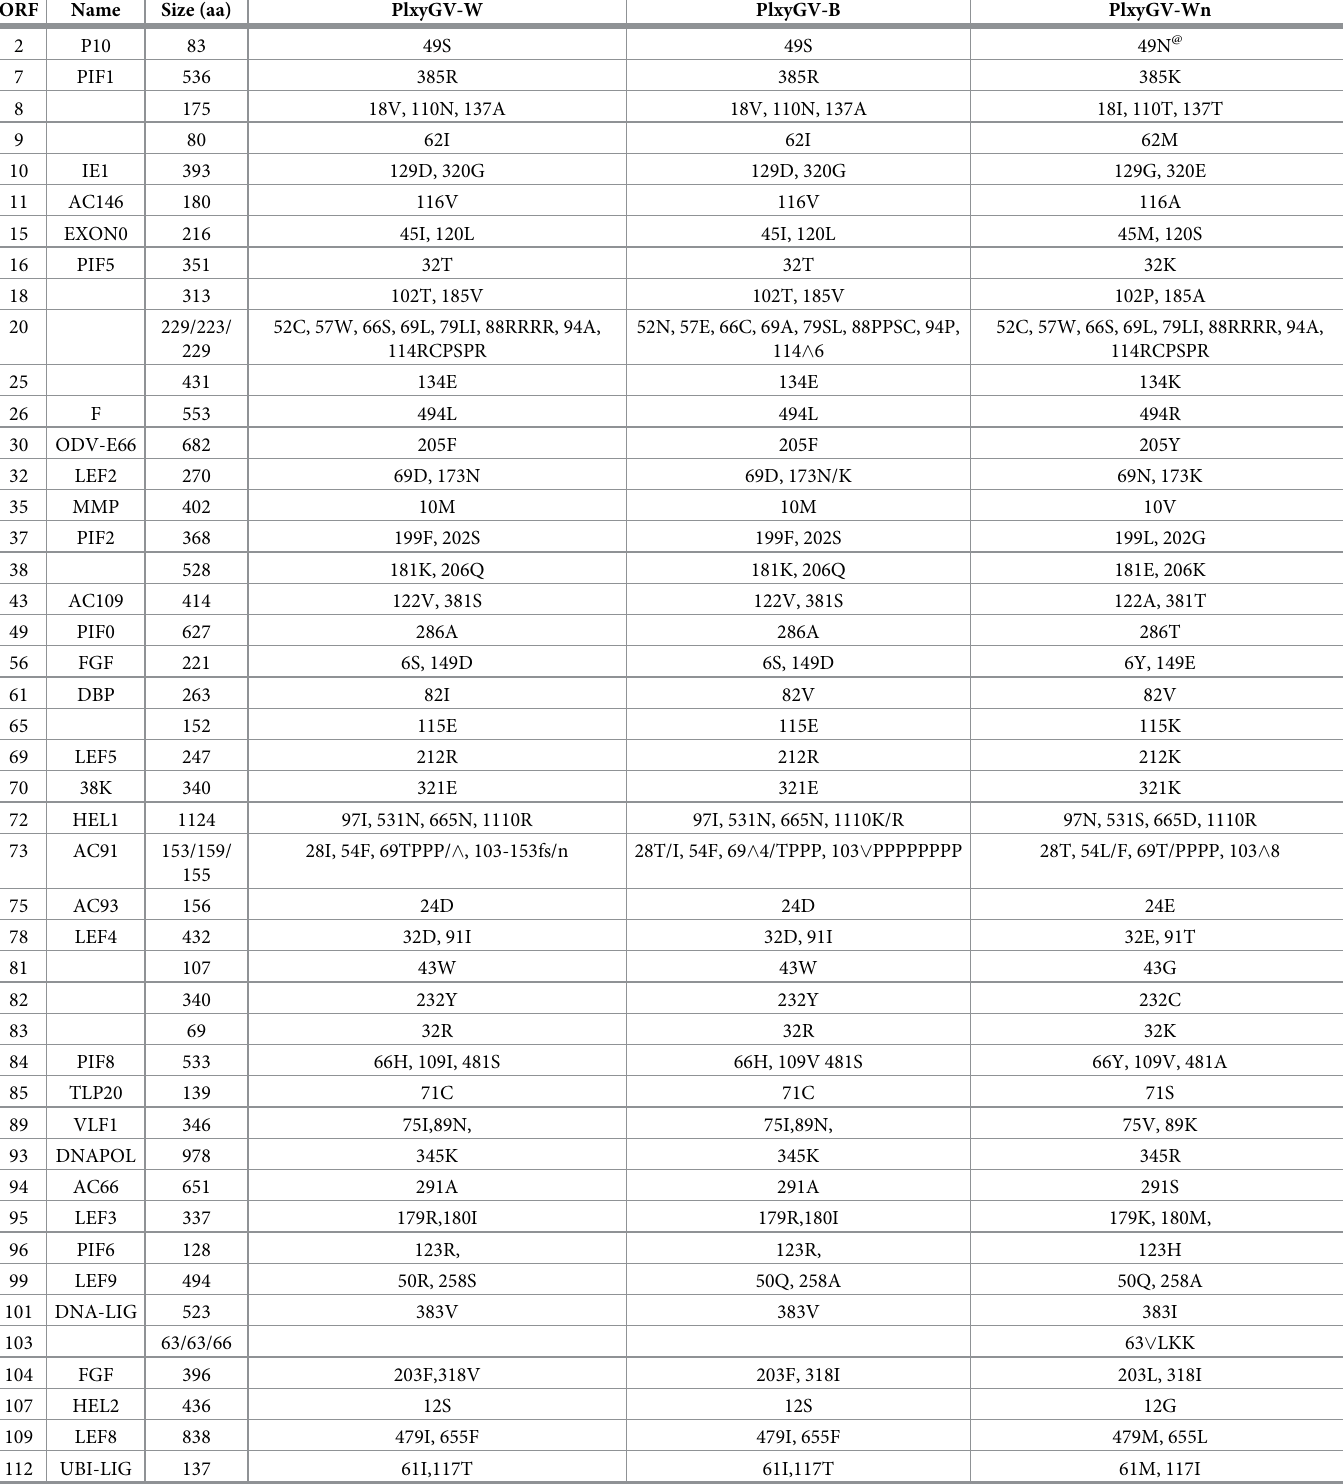
Table 2. Nonsynonymous mutations in PlxyGV-W, PlxyGV-B and